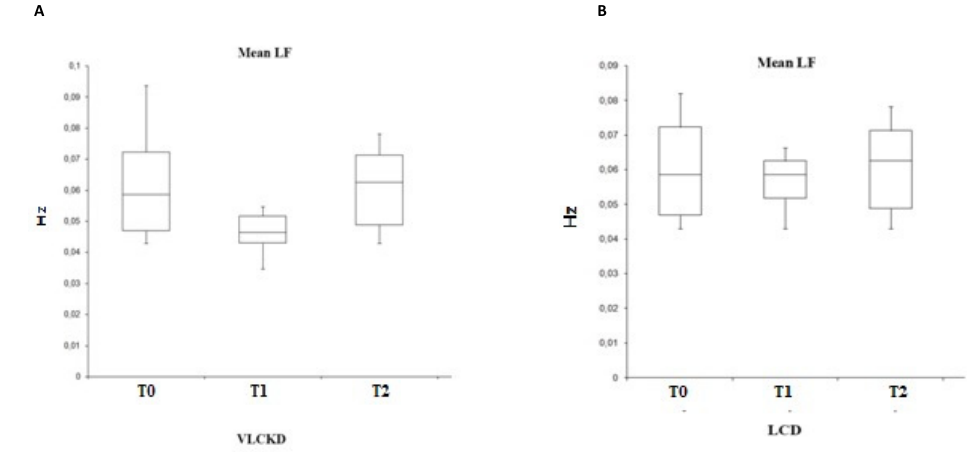
Figure 5. Variability of the mean LF in VLCKD subjects (A) and in LCD subjects (B).